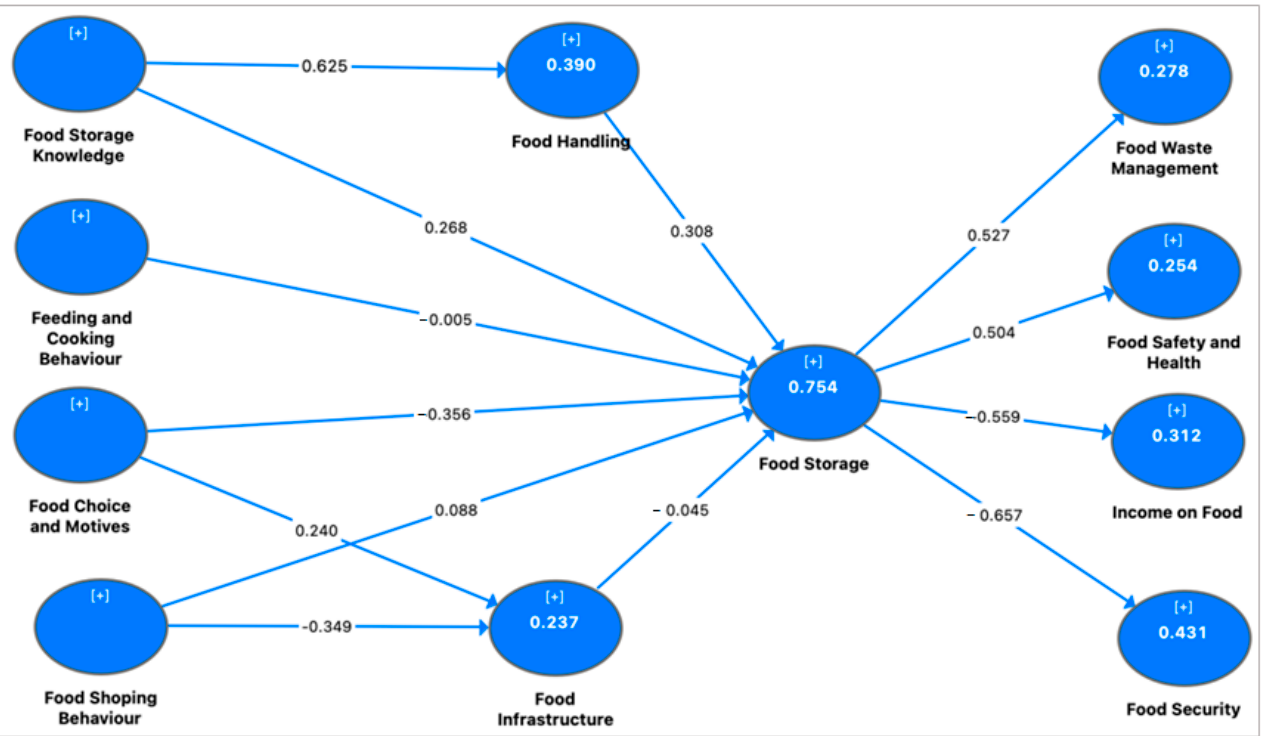
Figure 4. Network analysis of determinants of household-level food storage practices and outcomes on food safety and security. The +/- indicates the strength of the relationship between and among the clustering variables. The [+] indicates positive relationship between clustering variables.